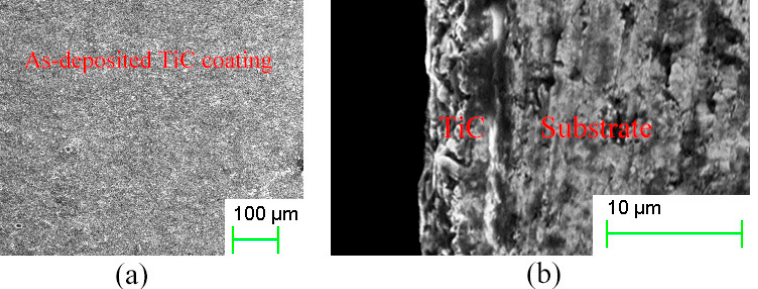
Figure 2. SEM micrograph showing the morphology of the as-deposited TiC thin film: ( a ) Surface ( b ) cross-section.